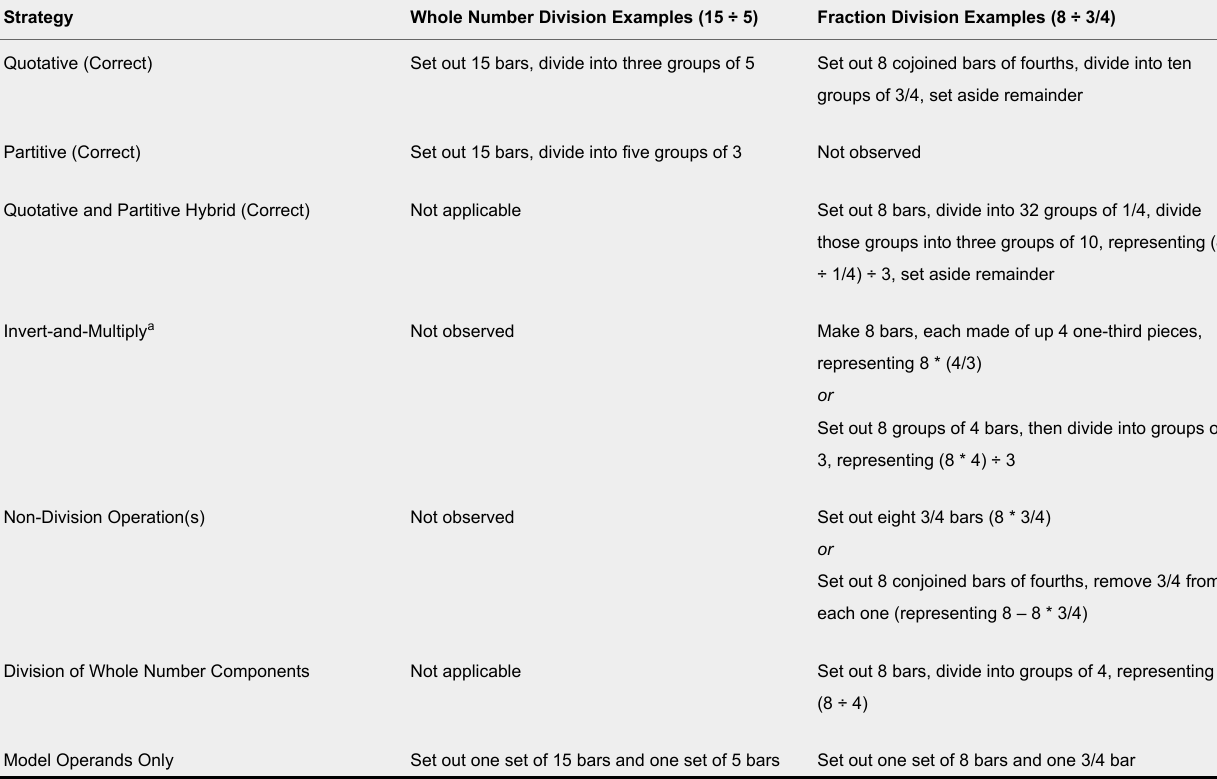
Strategies for Modeling Division